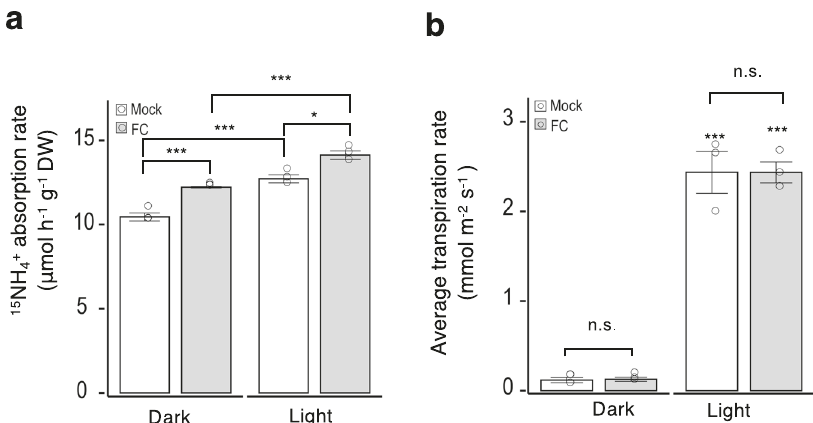
Fig. 1 Plasma membrane (PM) H + -ATPase regulates ammonium (NH 4 + ) uptake in rice. a 15 NH 4 + absorption rate in wild-type (WT) rice. To determine + absorption rates, rice seedlings were incubated in 2 mM 15 NH + solution with 5 μ M fusicoccin (FC) for 30 min under dark or illuminated 15 NH 4 4 conditions. b Average transpiration rates of rice leaves under dark and illuminated conditions over 30 min. Small circles in a , b represent data points for individual experiments; three biological replicates were analysed for each treatment. Columns and error bars in a , b represent the means ± standard errors (SEs; n = 3). Differences were evaluated using the two-tailed Student ’ s t test (* P < 0.05; *** P < 0.005; n.s., not signi fi cant). The exact P values are 0.0018 (mock in dark vs. FC in dark), 0.0025 (mock in dark vs. mock in light), 0.0143 (mock in light vs. FC in light) and 0.0016 (FC in dark vs. FC in light) for ( a ); 0.8194 (mock in dark vs. FC in dark), 0.0006 (mock in dark vs. mock in light), 0.0851 (mock in light vs. FC in light), and 4.27 × 10 − 5 (FC in dark vs. FC in light) for ( b ). n.s. Not signi fi